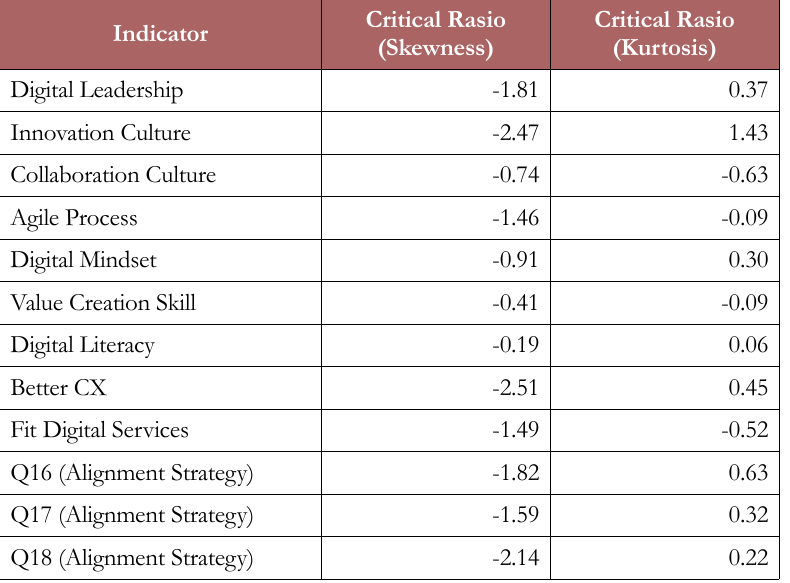
Table 3. Critical